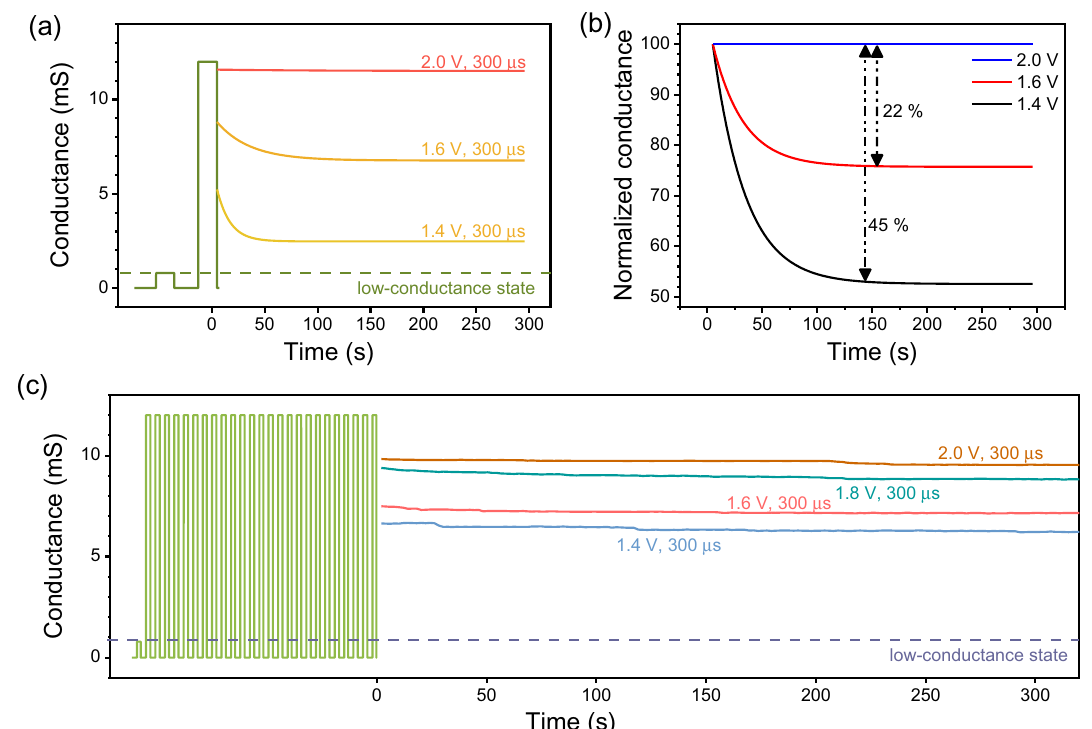
Figure 6. STP and LTP characteristics of the Ag/ZnO/TiN device. ( a ) Current decay characteristics after one pulse response. ( b ) Normalized conductance decay for the observation of STP. ( c ) LTP by multiple pulse inputs with different pulse voltage